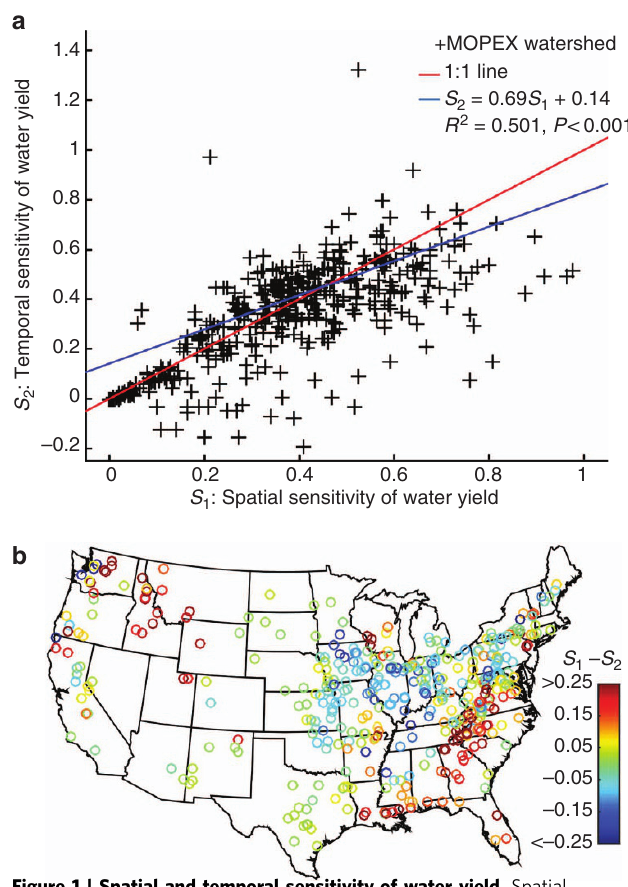
Figure 1 | Spatial and temporal sensitivity of water yield. Spatial sensitivity of water yield (x-axis) and temporal sensitivity of water yield (y-axis) for 420 watersheds located in the United States ( a ), and the spatial pattern of their differences ( b